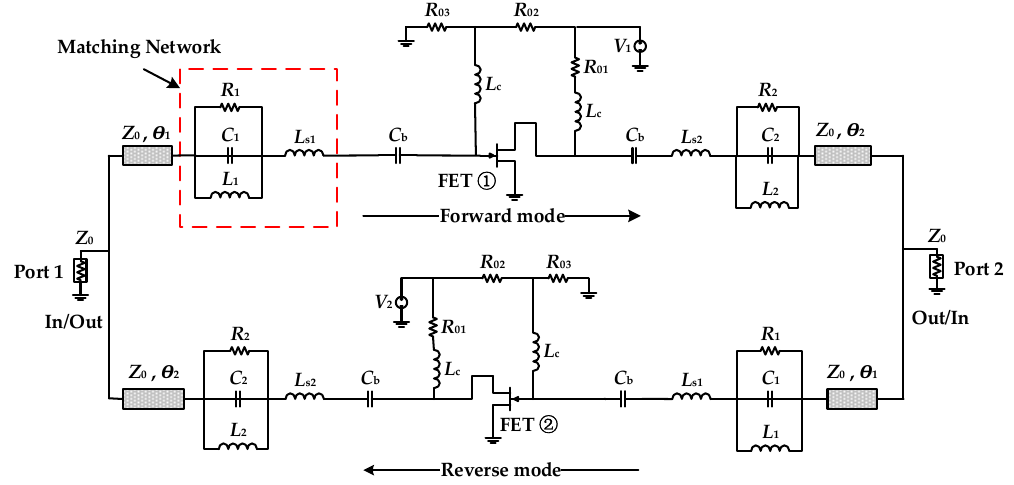
Figure 4. Schematic of the proposed switch-less bi-directional low-noise amplifier. Table 1. Working